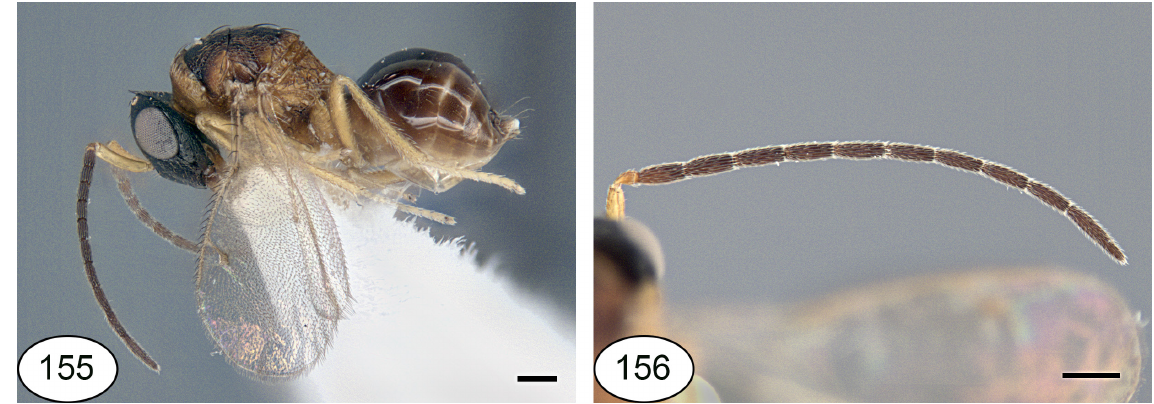
Figs 155–156. Netomocera ramakrishnai Sureshan, 2010, ♂, Japan. 155 . Habitus, lateral view. 156 . Antenna. Scale bars: 0.2